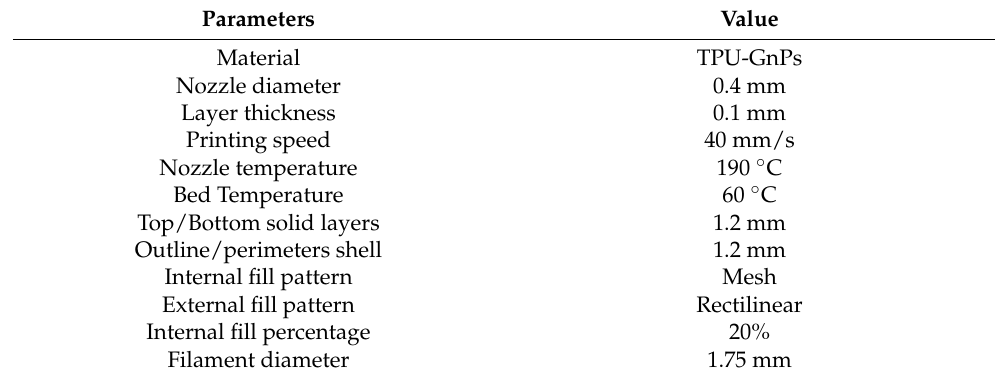
Table 1. 3D printer